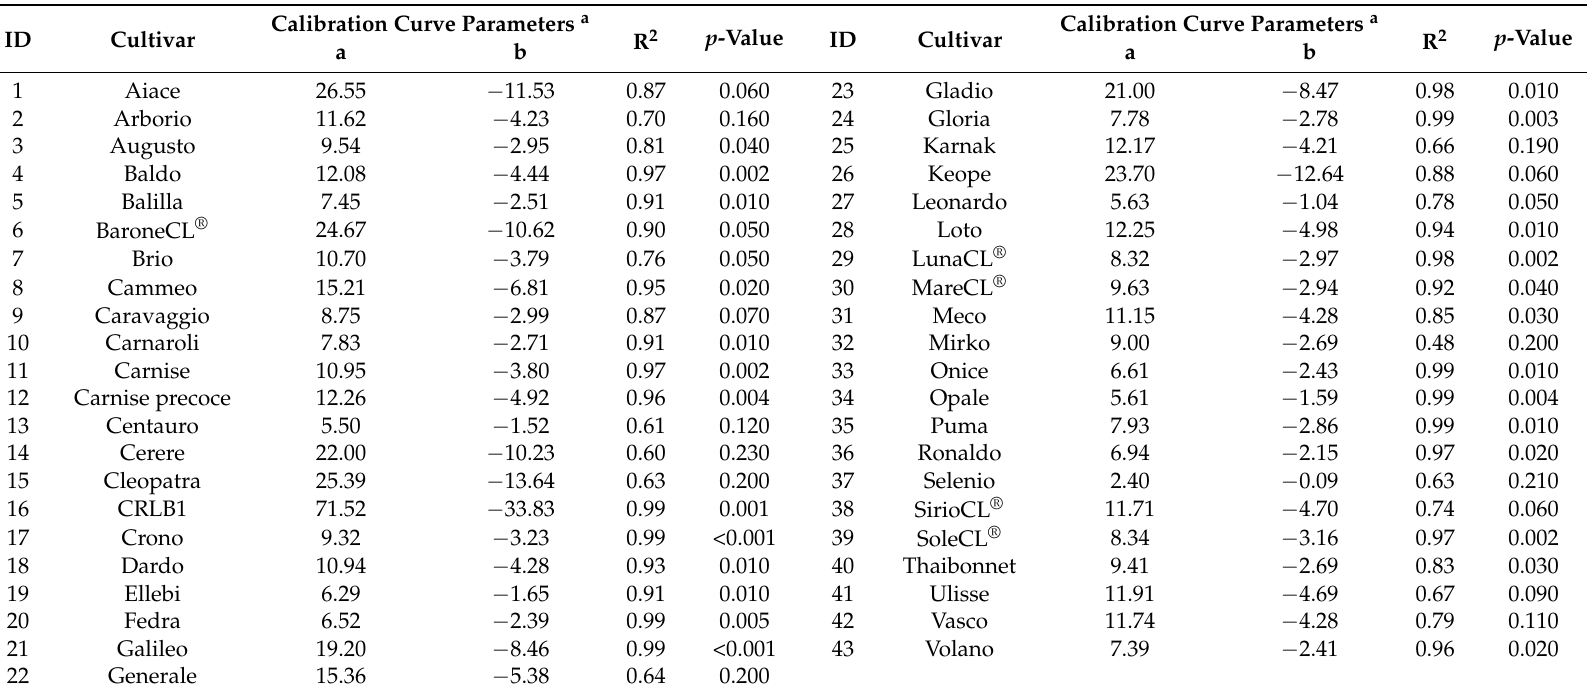
Table 1. Calibration curves, R 2 and p -values derived from the PocketN index (–) and reference plant nitrogen content (PNC, %, from elemental analyzer) for the 43 rice varieties involved in the